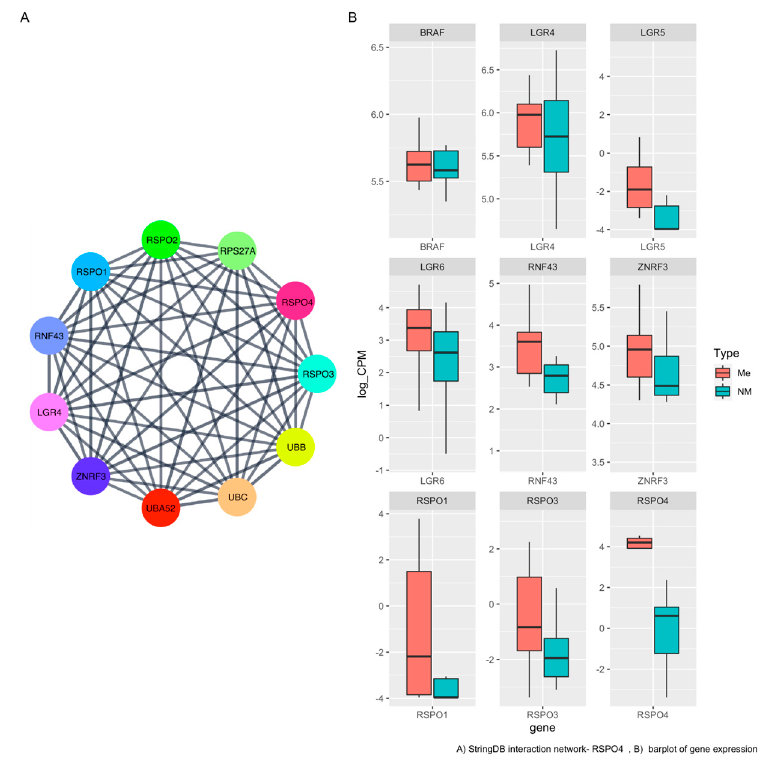
Figure 3. RSPO4 protein–protein interaction (PPI) network and expression level ( A ) Network graph of physical interacting partners of RSPO4 and the ligands using stringDB. ( B ) Representative boxplot of gene expression levels between metastatic and non-metastatic our PTC samples.